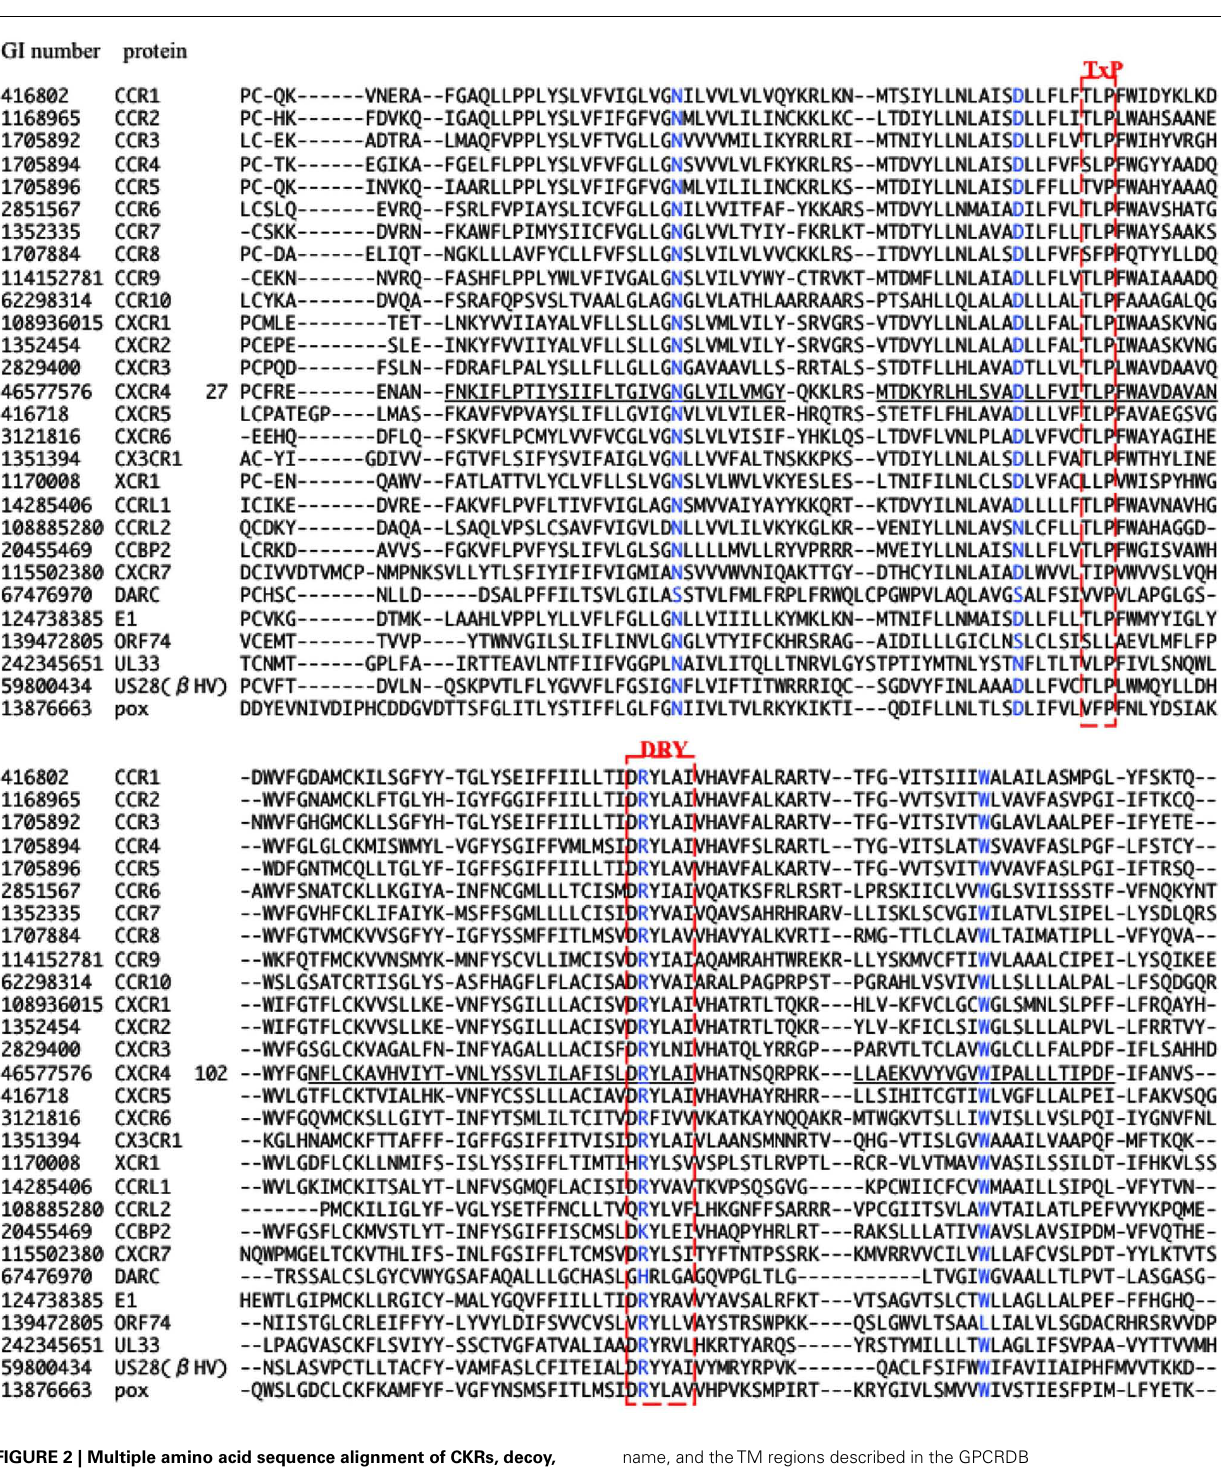
name, and theTM regions described in the GPCRDB (http://www.gpcr.org/7tm/) are indicated by underlines.The corresponding sites for x.50 of Ballesteros–Weinstein nomenclature are colored blue. Four motifs,TxP, DRY, CWxP, and NPxxY 5-6 F, are enclosed by red